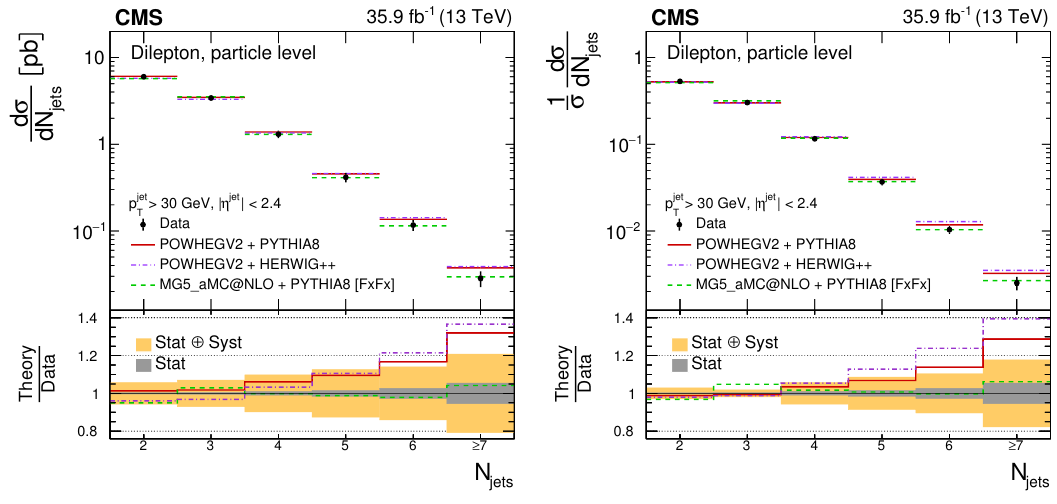
Figure 51 . The di(cid:11)erential tt production cross sections as a function of N jets in a (cid:12)ducial phase space at the particle level are shown for the data (points) and the MC predictions (lines). The vertical lines on the points indicate the total uncertainty in the data. The left and right plots correspond to absolute and normalised measurements, respectively. The lower panel in each plot shows the ratios of the theoretical predictions to the data. The dark and light bands show the relative statistical and total uncertainties in the data, respectively.